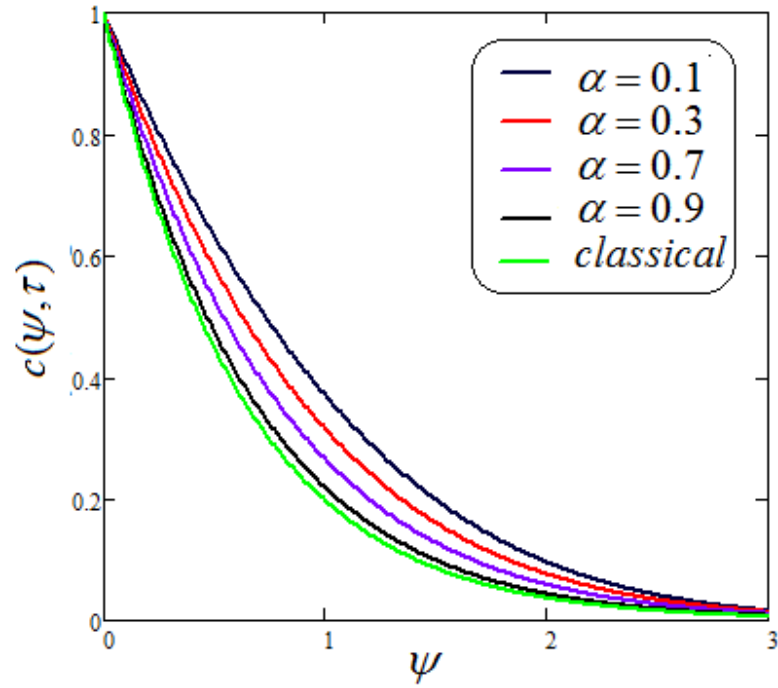
Figure 17. Trace of concentration for dissimilar values of α .